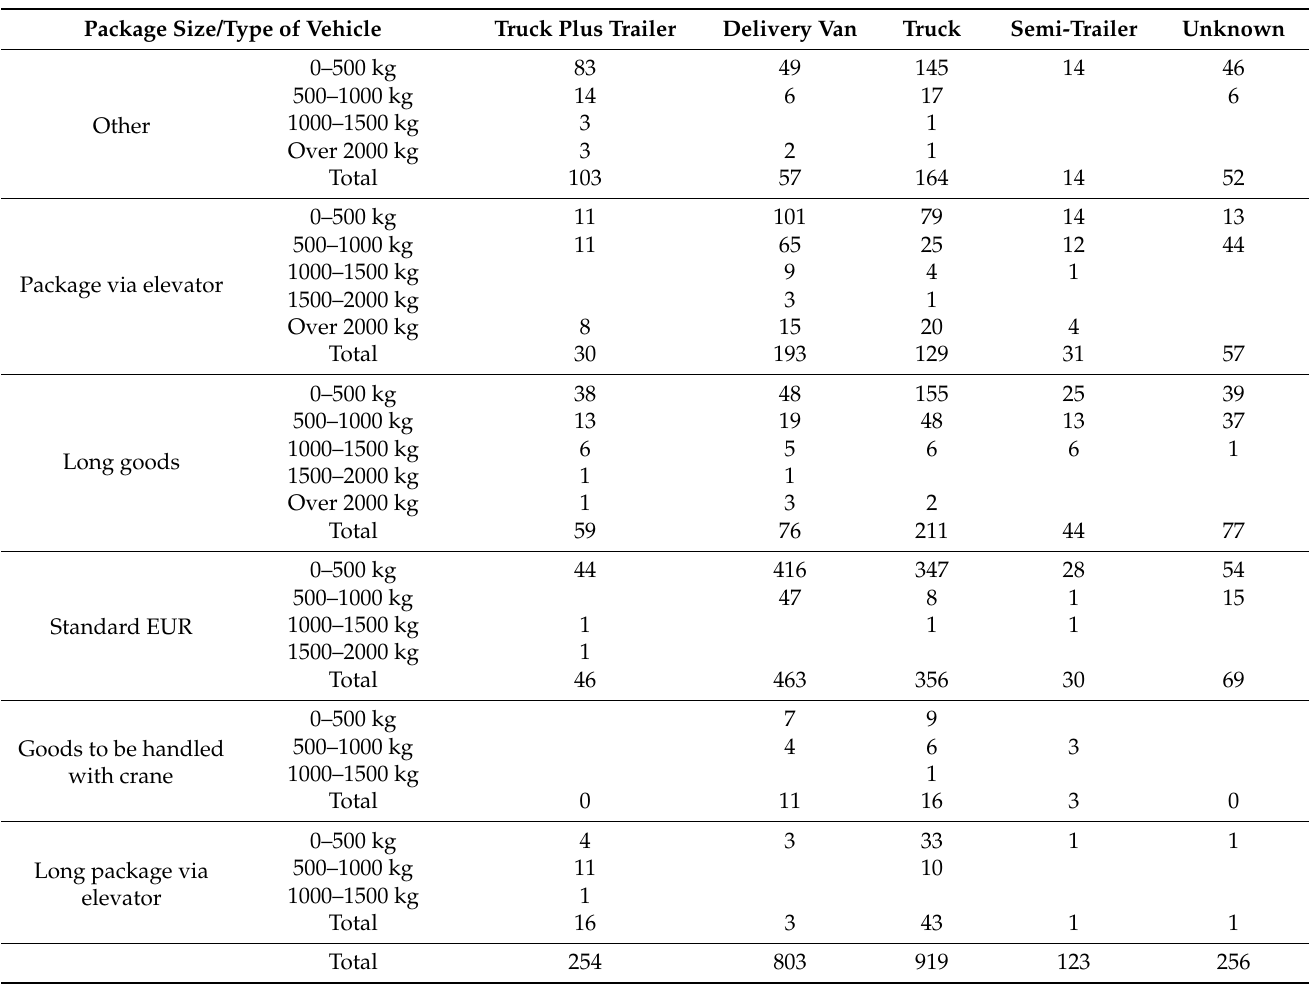
Table 3. Types of vehicle used in delivering